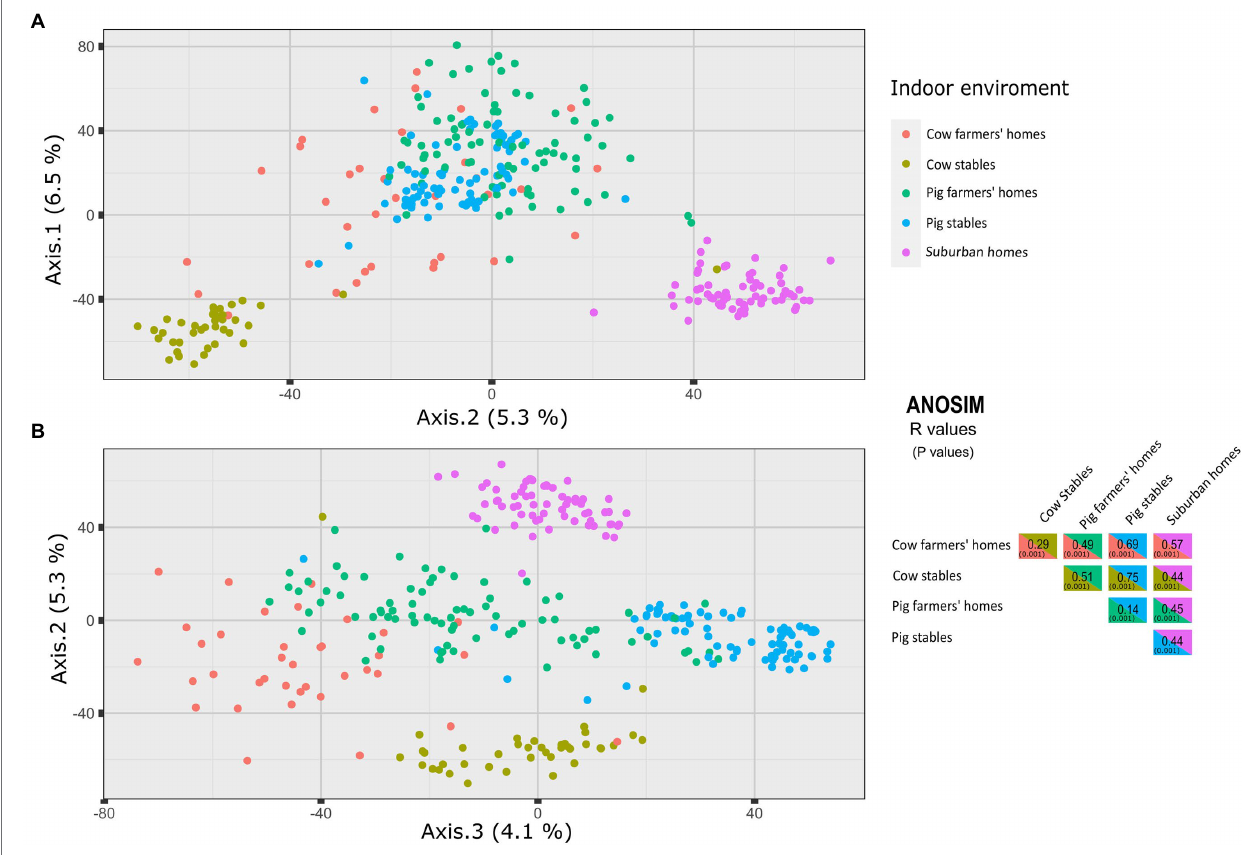
FIGURE 3 | Principal coordinates analysis (PCoA) of axes 1 vs. 2 (A) , 2 vs. 3 (B) of microbial community structures using Aitchison dissimilarity matrix. The figure shows a significant separation between different indoor environments. On the right side, ANOSIM R metric is used to infer the degree of difference between the environment types, where 1 means very different bacterial communities and 0 means very similar bacterial communities. Values in parentheses are p